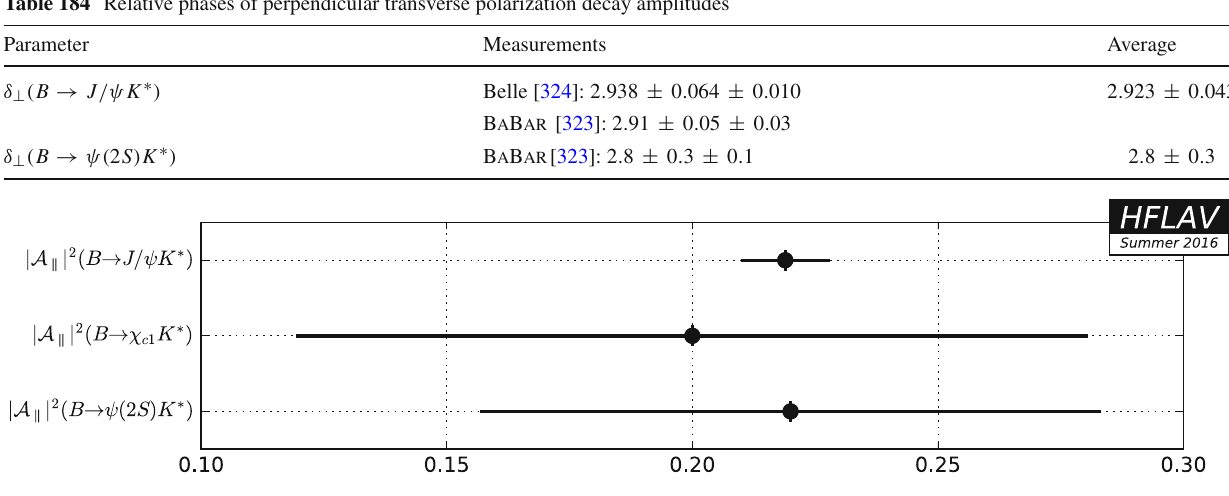
Fig. 146 Summary of the averages from Table